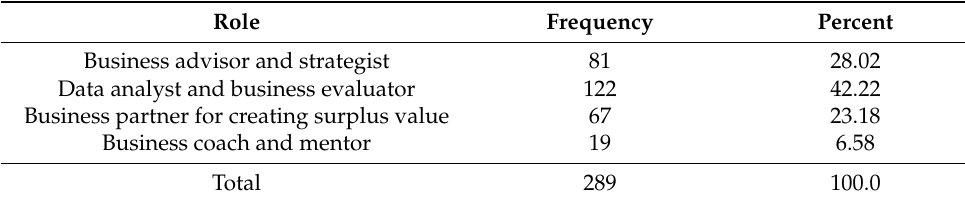
Table 13. The role of the professional accountant in a digital environment.